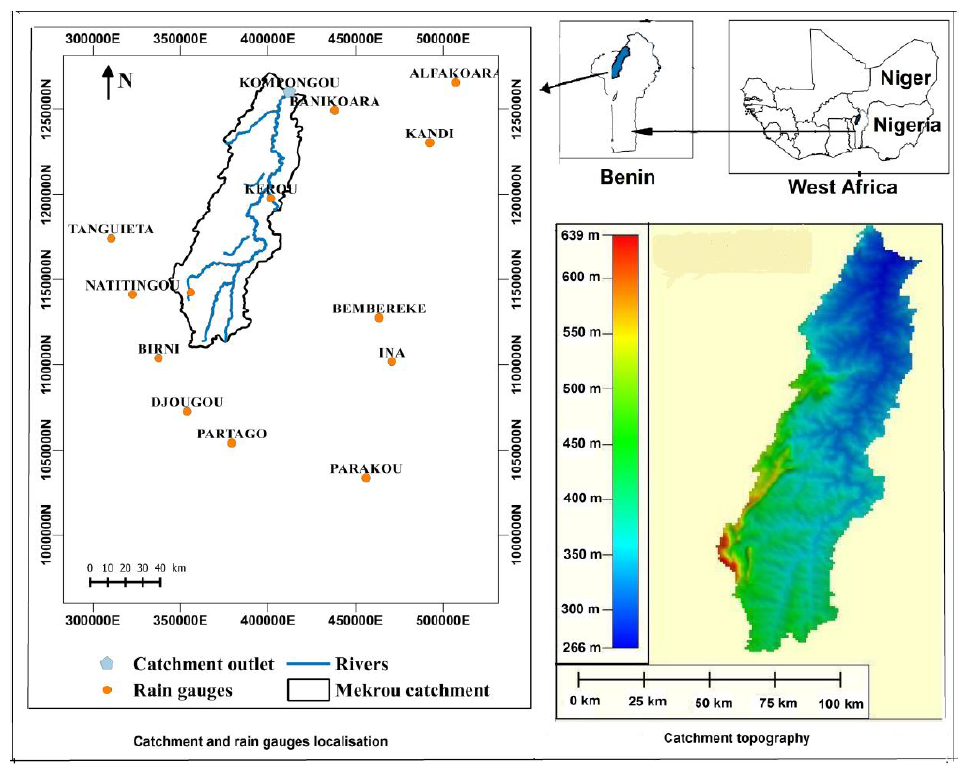
Figure 2 . Study area. Figure 2. Study area. Table 1 . Main characteristics of the RCMs. Table 1. Main characteristics of the